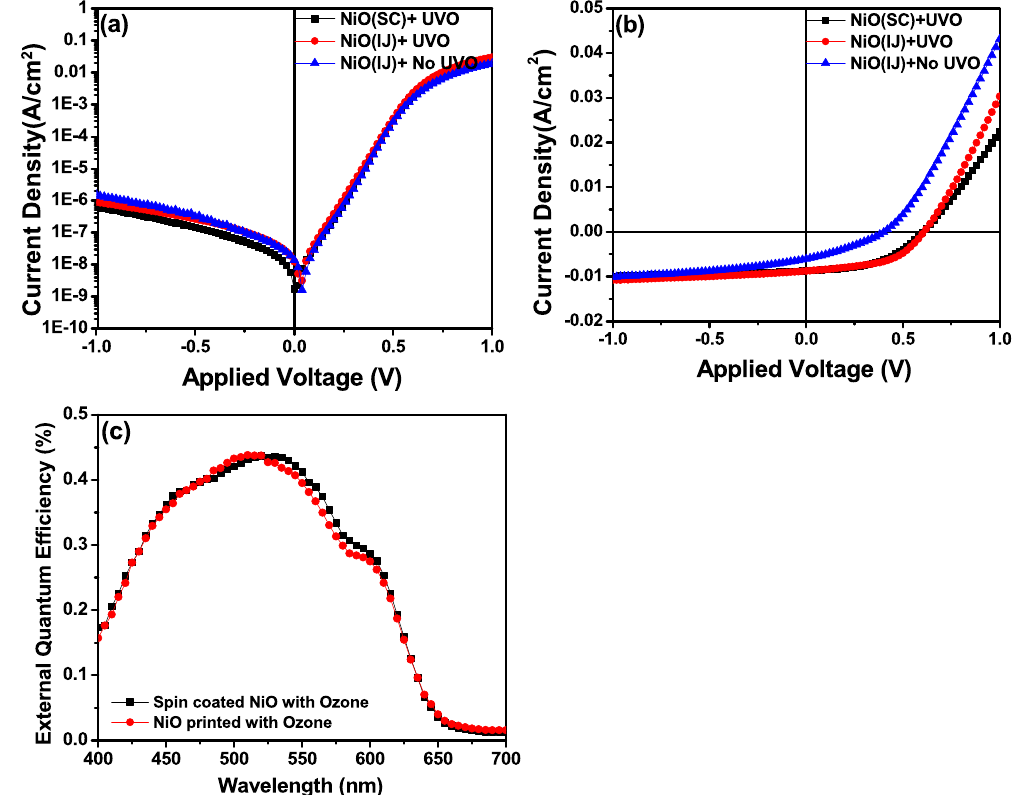
Figure 8. ( a ) Dark and ( b ) lightJ-V characteristics of P3HT:PC 60 BM organic solar cell devices fabricated on printed and spin coated NiO films heat treated at 400 °C (with and without UV-Ozone treatment) and ( c ) EQE spectra of the devices fabricated on spin coated and printed NiO films heat treated at 400 °C.